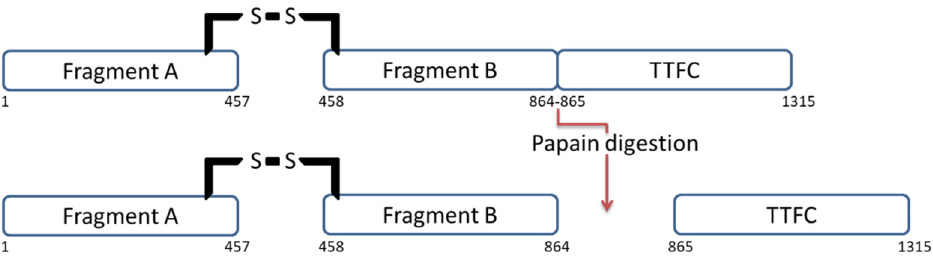
Figure 1. TT structure before and after papain digestion. Papain digests the protein by splitting it into two fragments: TTFC and fragment A-B.